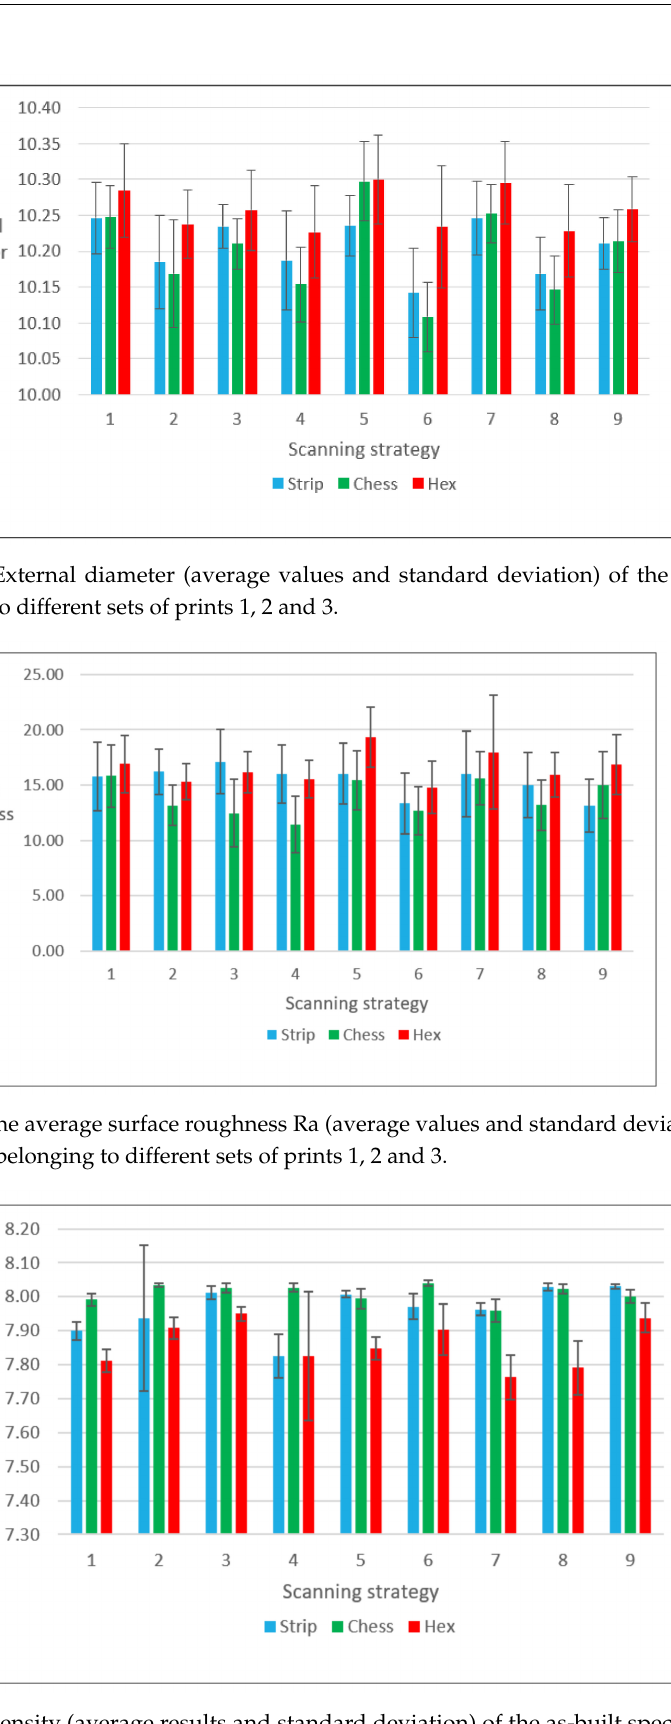
Figure 6. Density (average results and standard deviation) of the as-built specimens belonging to different sets of prints 1, 2 and